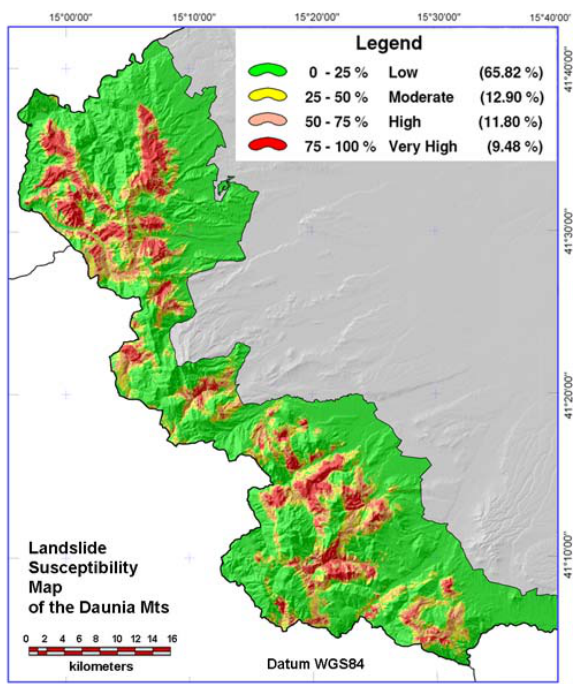
Figure 8. Susceptibility map produced by the LR analysis. 2 Fig. 8. Susceptibility map produced by the LR